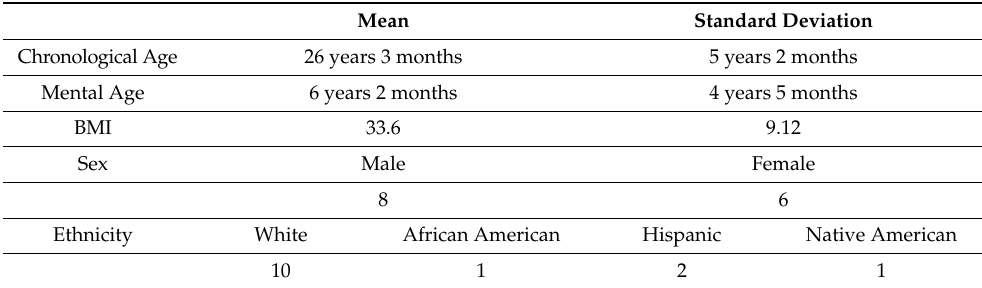
Table 1. Participant